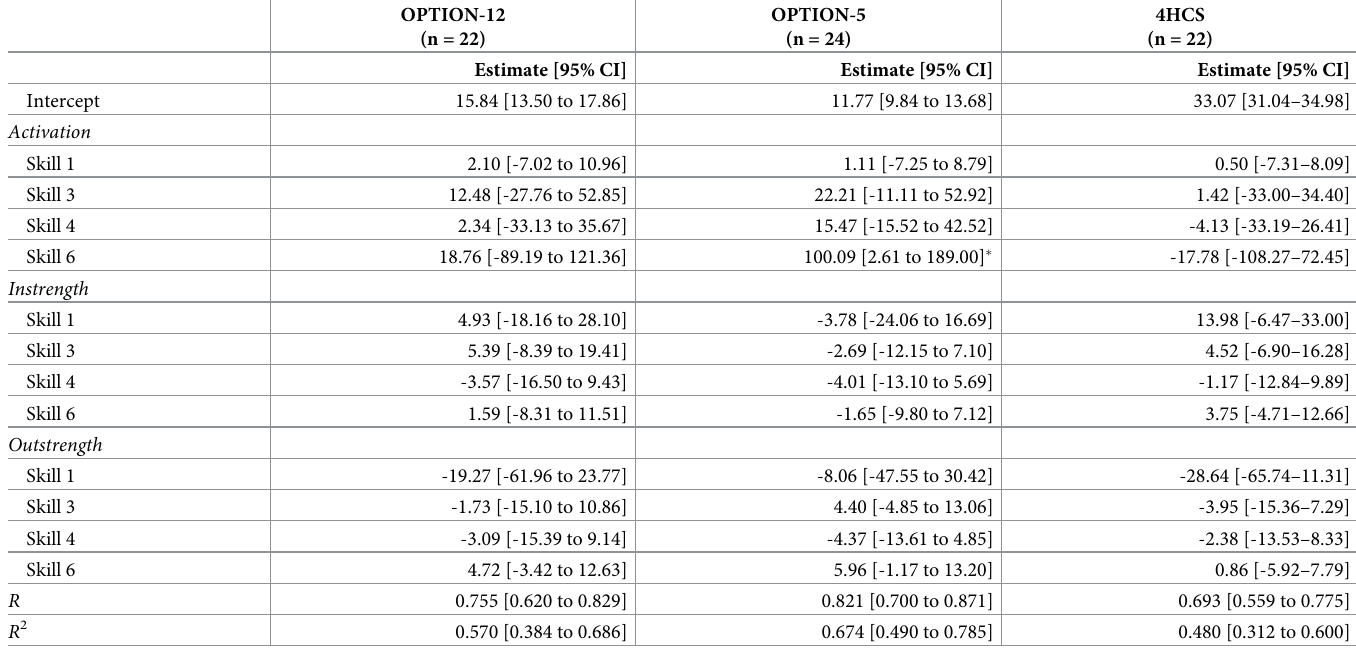
Table 4. Exploratory prediction of observed SDM competence from network